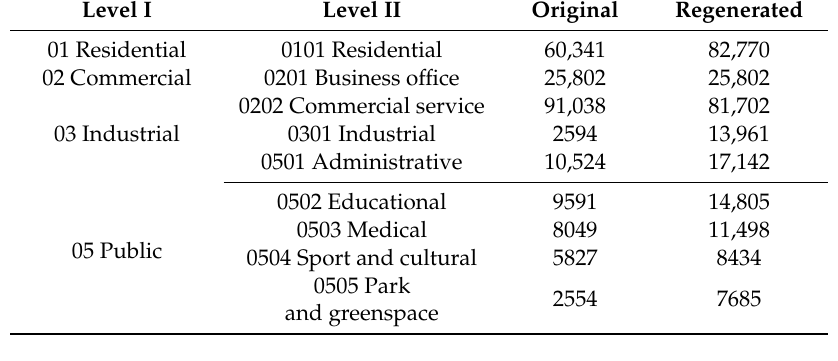
Table 3. A comparison of original POIs and the regenerated POIs in number.